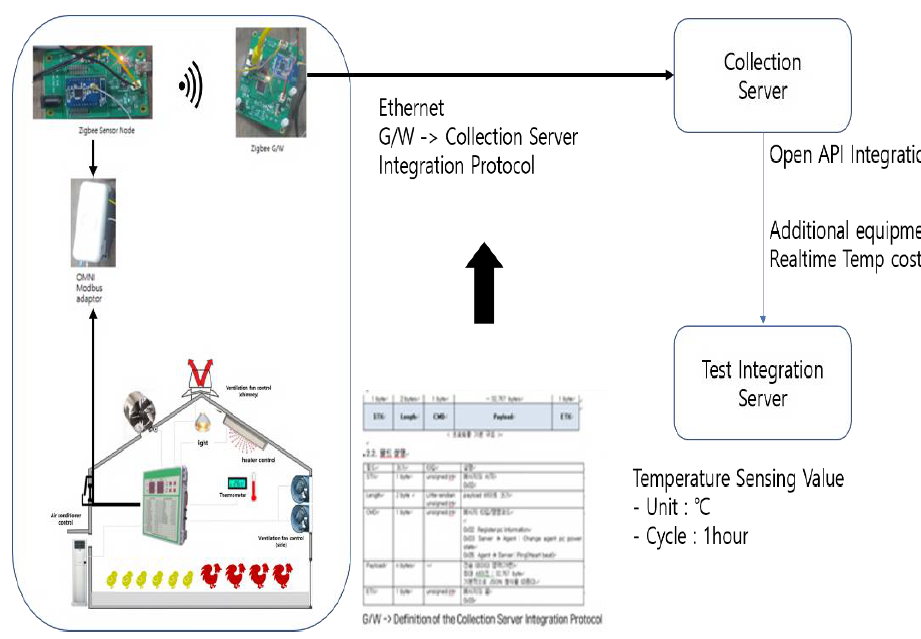
Figure 9. Procedures for configuring a test environment. Table 9. Key functions of the test equipment used in the experiment.